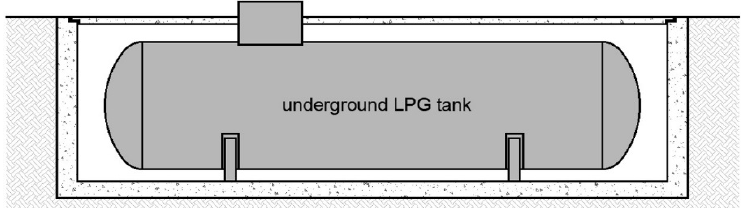
Figure 8. Sectional diagram of the concrete shelter for the underground tanks.